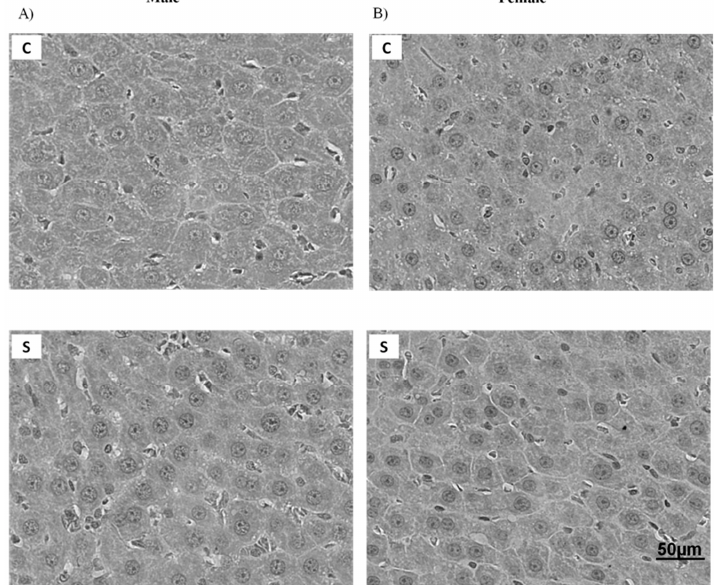
Figure 2. Representative photomicrographs (×60; hematoxylin-eosin) of the liver of adult rats programmed by smoke exposure during the lactation period. ( A ) morphology of C and S males; ( B ) morphology of C and S females. Both groups presented typical architecture, with no inflammatory cell infiltrate or drops of lipids in their cytoplasm. Groups: C—CONTROL and S—SMOKE ( n = 6 rats/group).